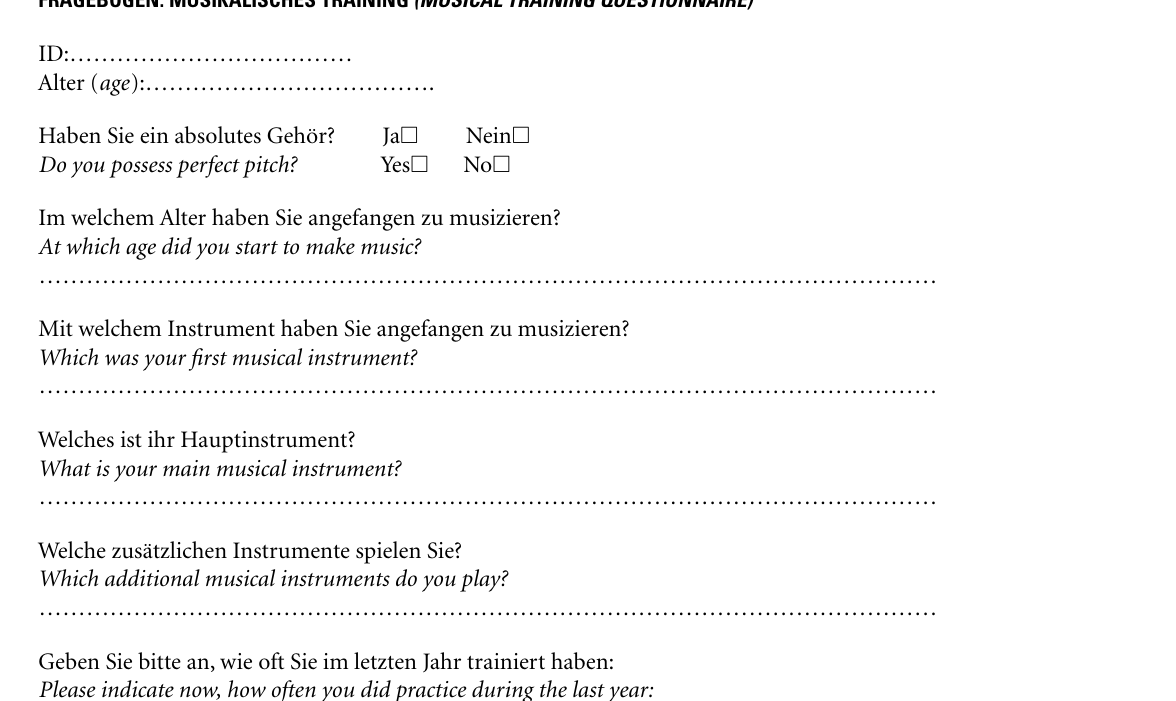
FRAGEBOGEN: MUSIKALISCHES TRAINING (MUSICAL TRAINING